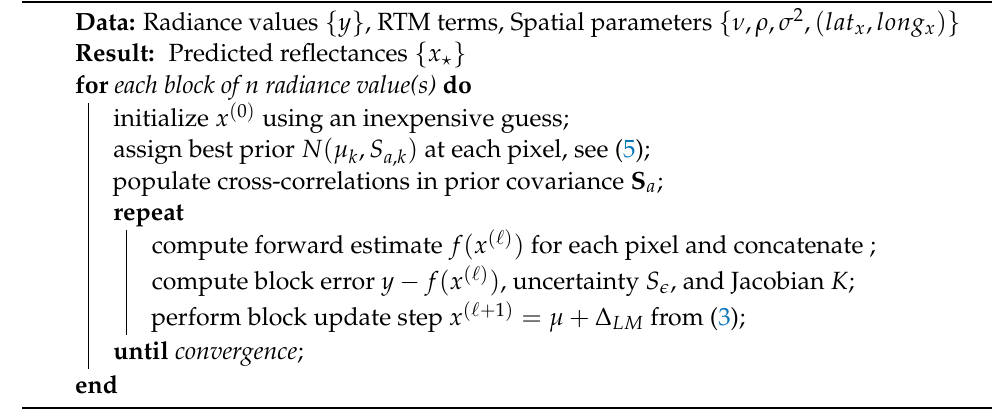
Algorithm 1: Simplified Optimal Spatial